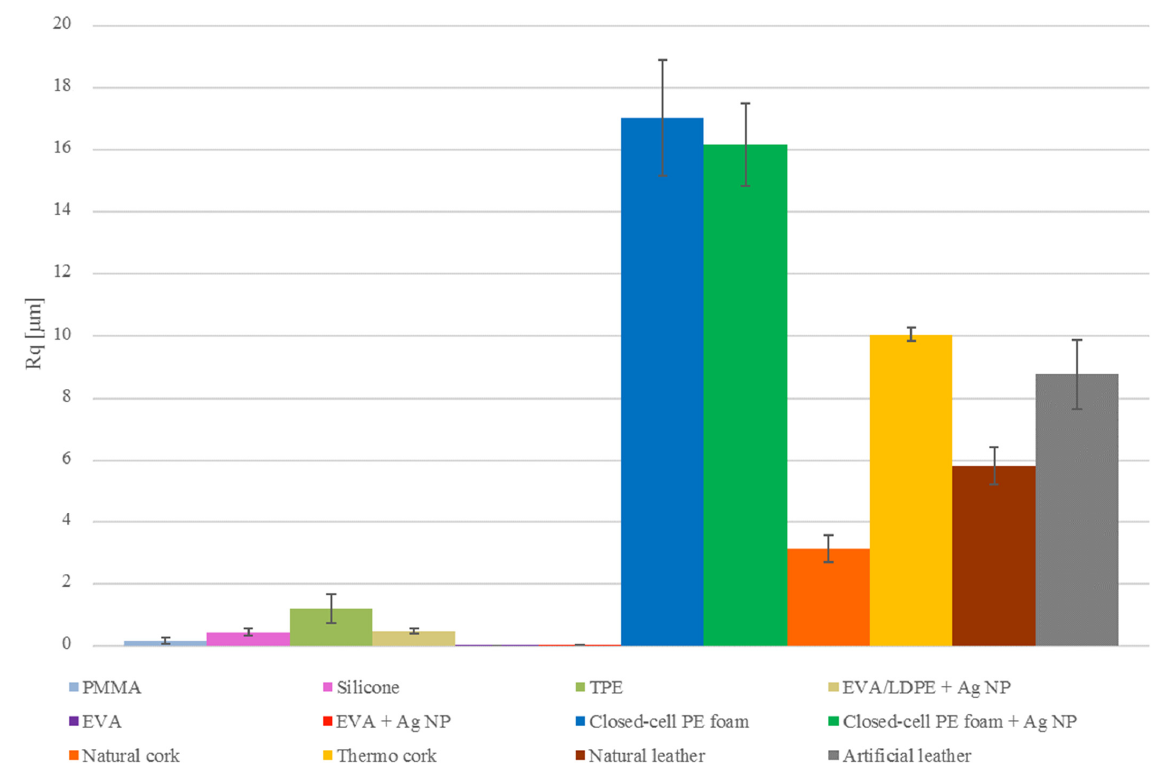
Coatings 2021 , 11 , x FOR PEER REVIEW Figure 1. RMS roughness R q of orthotic and prosthetic surfaces measured with the profilometer.